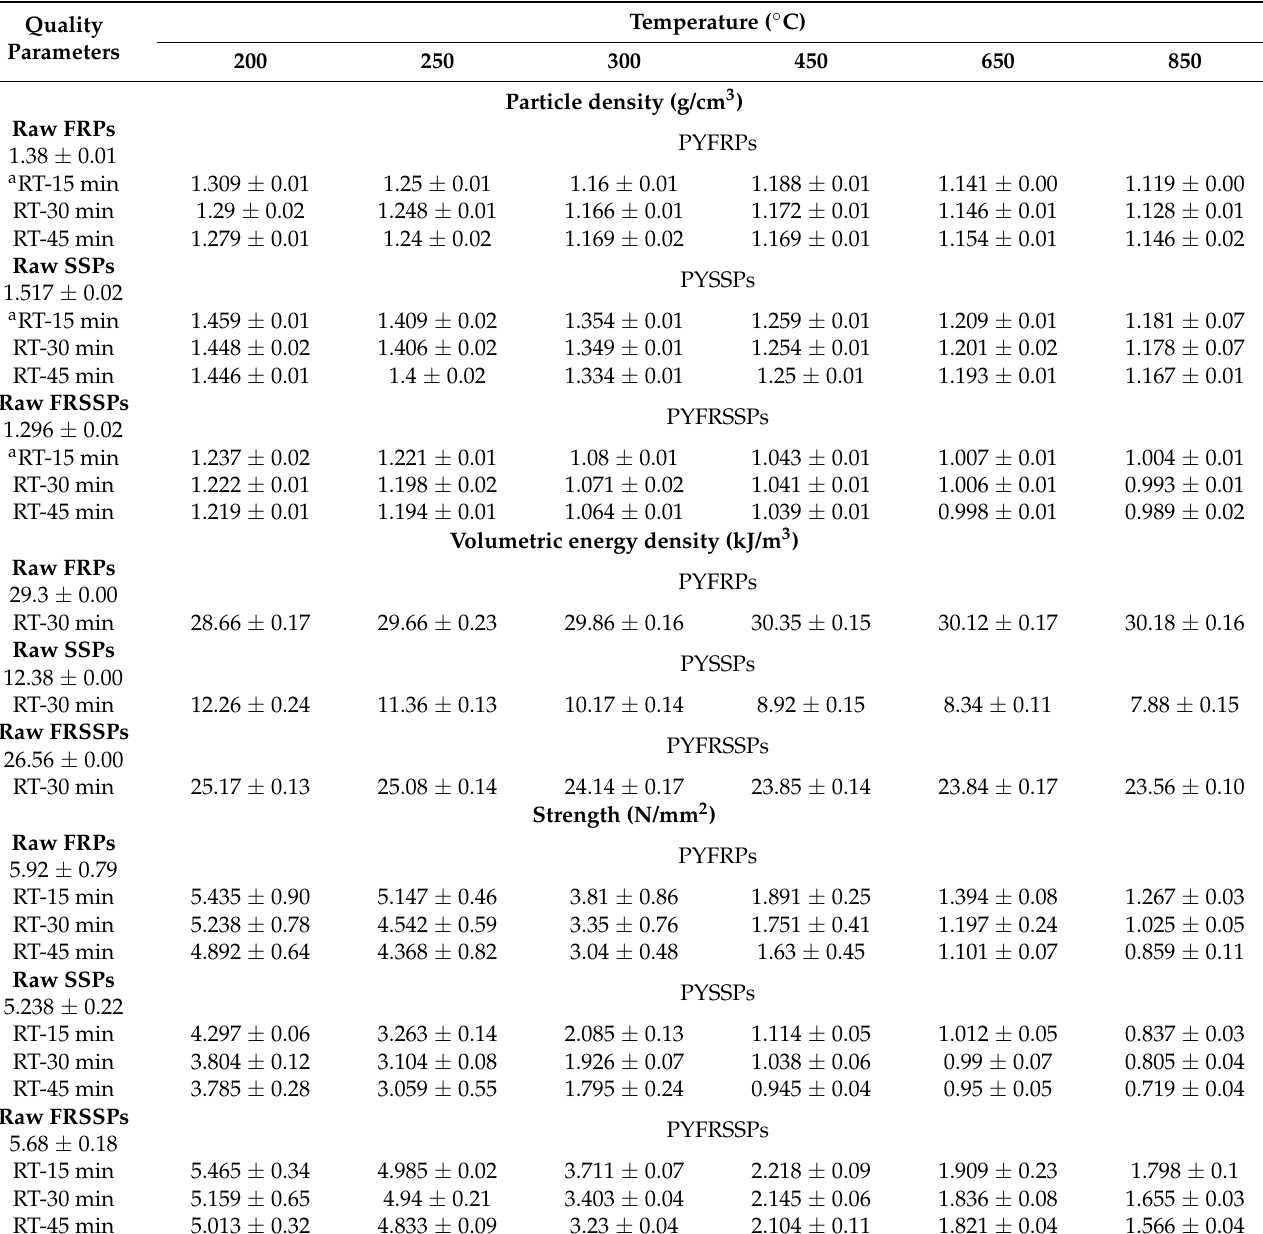
Table 1. Physical and mechanical characteristics of pellets. Adapted with permission from Ref. [67]. 2022,